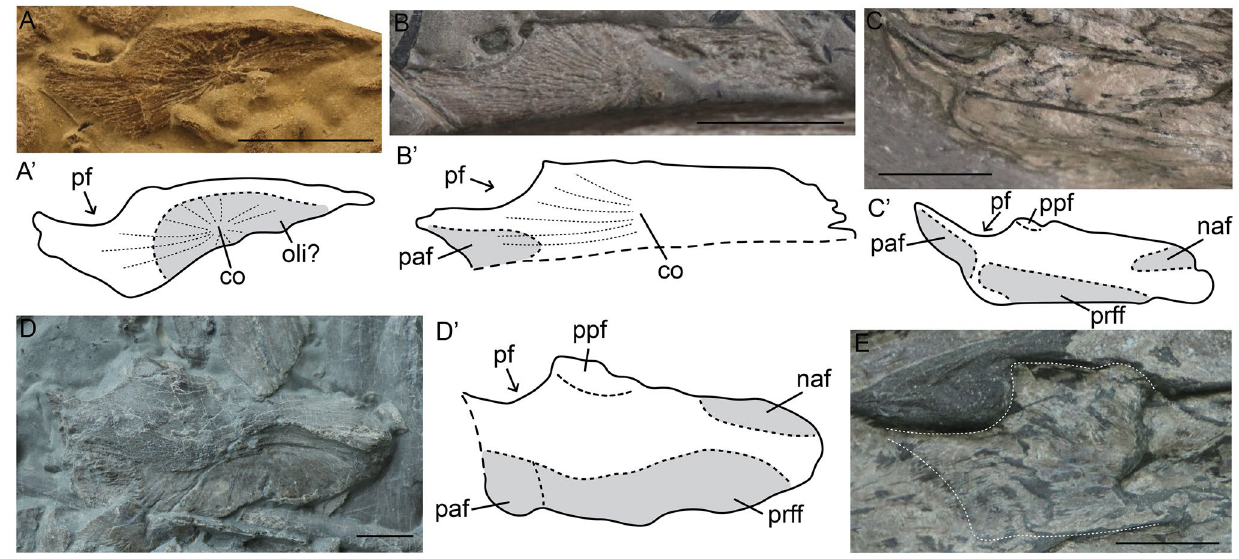
Figure 4. Frontals of selected specimens of Stenopterygius in ventral ( A ) and dorsal ( B – E ) view. Interpretative drawings denoted by an apostrophe with their corresponding letter. ( A ) stage 3 embryo S. quadriscissus SMNS 80234; ( B ) stage 4 embryo S. quadriscissus SMNS 81961; ( C ) postnatal 1 S. quadriscissus SMNS 82046; ( D ) sexually mature S. quadriscissus SMNS 80234; ( E ) postnatal 2 S. quadriscissus SMNS 54026. co centre of ossification, naf nasal facet, oli olfactory lobe indentation, paf parietal facet, pf parietal foramen, ppf process anterior to the parietal foramen, prff prefrontal facet. Scale bar: ( A – E ) = 10